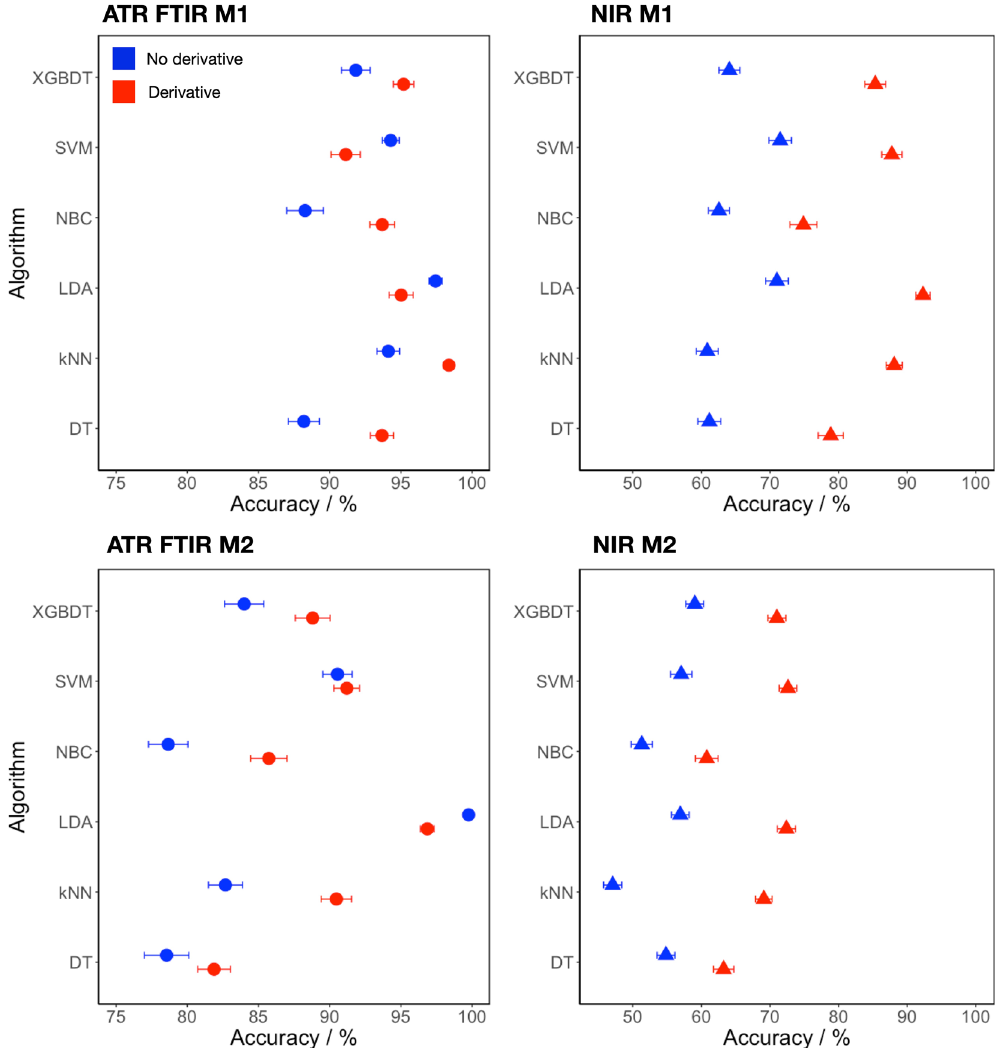
Figure 4. Classification accuracies of different classification algorithms used in the benchmarking procedure for the M1 and M2 classification models. Left: ATR FTIR models, right: NIR models. Blue is used to depict spectra, not processed with numerical differentiation, while red presents numerically differentiated spectra. The width of the interval presents the 95% confidence interval with the average at the centre.